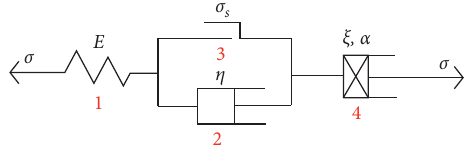
Figure 5: Improved Bingham model.